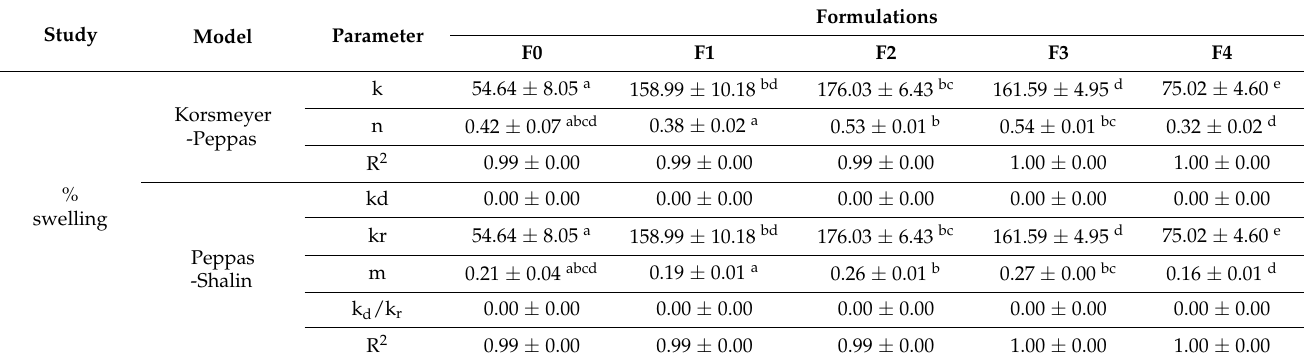
Table 1. Swelling parameters of the composite